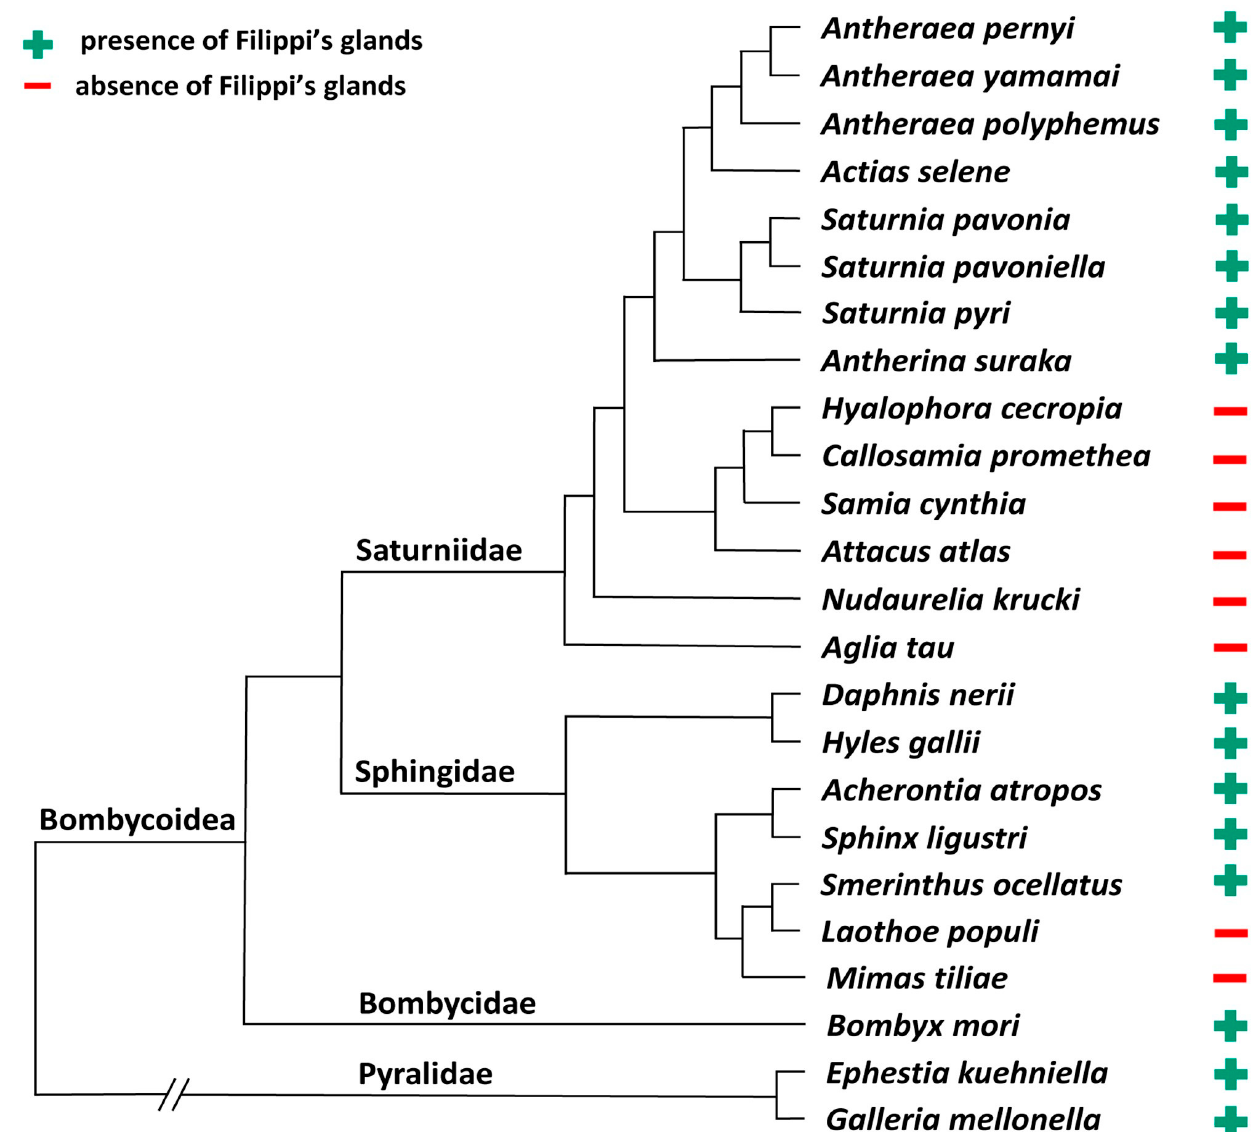
Figure 1. Simplified phylogenetic tree of Bombycoidea superfamily with respect to the species used in this study. The family Pyralidae serves as an outgroup [24].